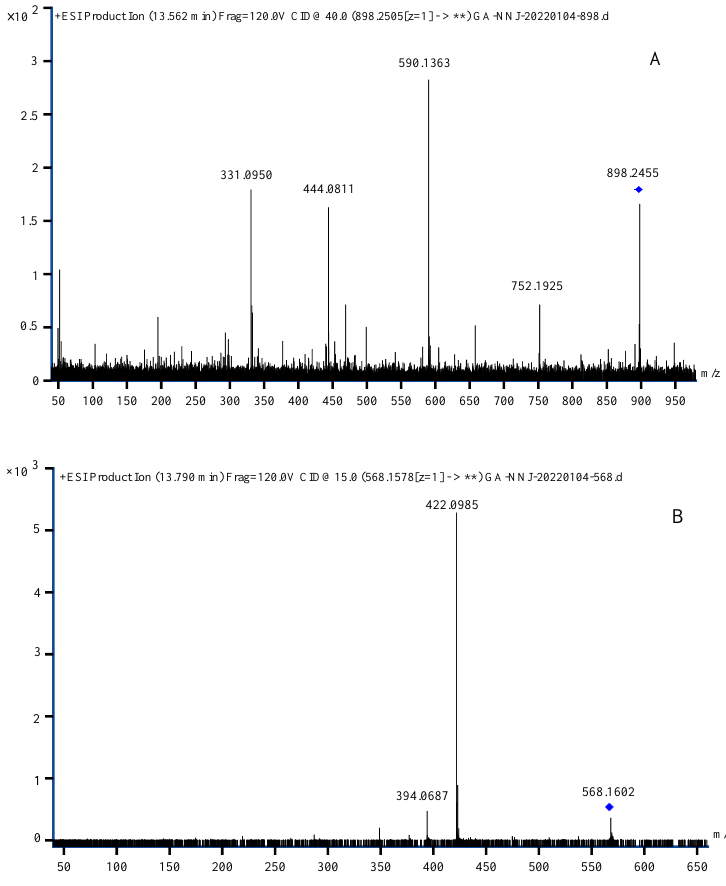
Figure 6. PIMS of m / z 898.2505 ( A ) and m / z 568.1578 ( B ) found in the extract of Arabidopsis thaliana (L.) exposed to Tabun. The blue sign was used to mark the precursor ion. Table 4. The deviations between calculated and observed m / z values of each fragment derived from compound 4.